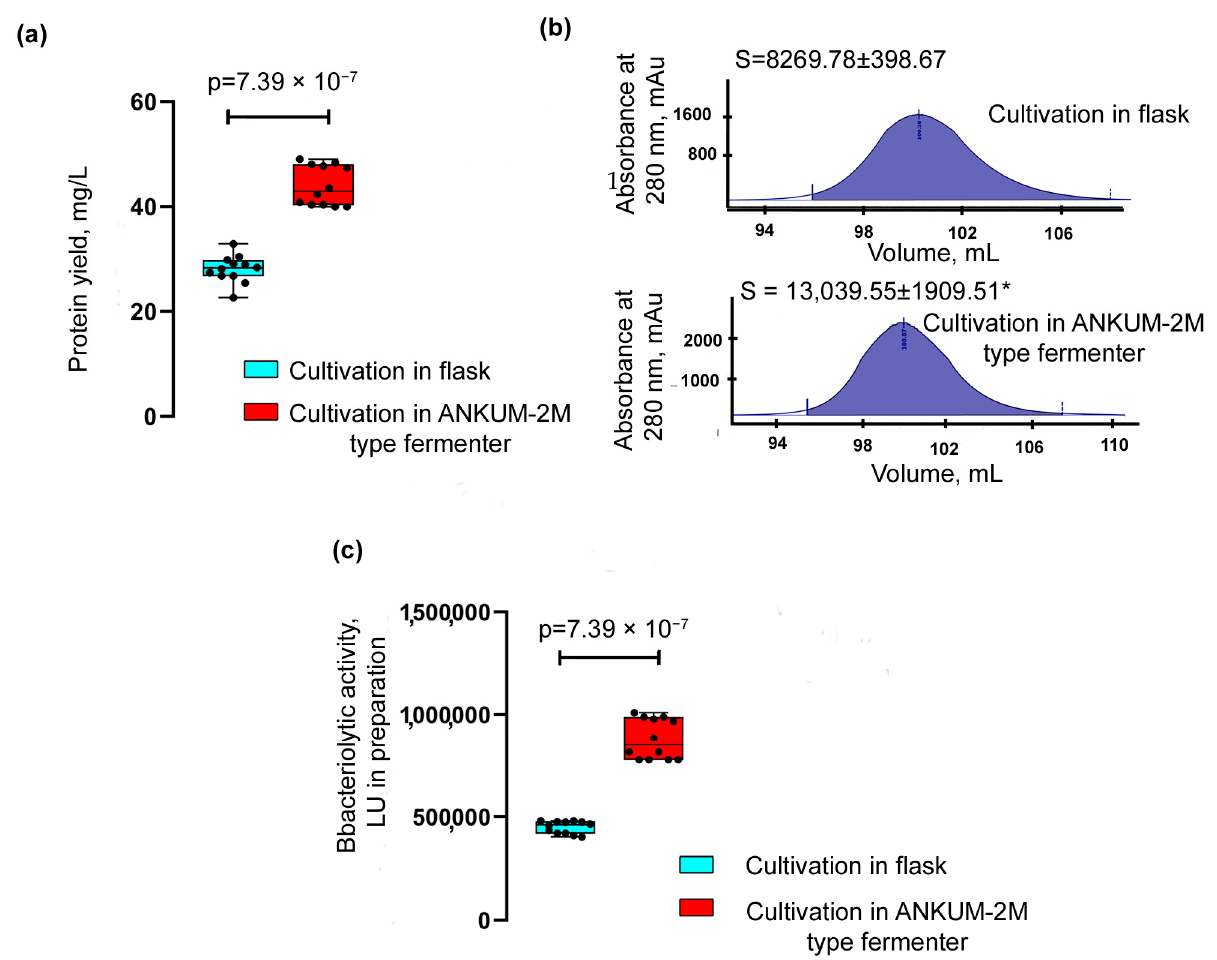
Figure 5. Assessment of Blp yield. ( a ) Comparison of the yield of the Blp protein of L. capsici P T5 - blp after cultivation in a fermenter and in flasks. The boxplots show the median and IQR. The values were obtained in two independent experiments, each with six technical replicates. The two groups were compared using a two-sided Mann–Whitney U -test. ( b ) Peak area of the Blp protein after purification on a Hiload 16/60 column (Superdex 75). The mean values were obtained in two independent experiments, each with two technical replicates. The two groups were compared using a two-sided Mann–Whitney U -test ( p = 0.0286). ( c ) Comparison of the bacteriolytic activity of the Blp of L. capsici P T5 - blp after cultivation in a fermenter and in flasks. The boxplots show the median and IQR. The values were obtained in two independent experiments, each with six technical replicates. The two groups were compared using a two-sided Mann–Whitney U -test. * p =